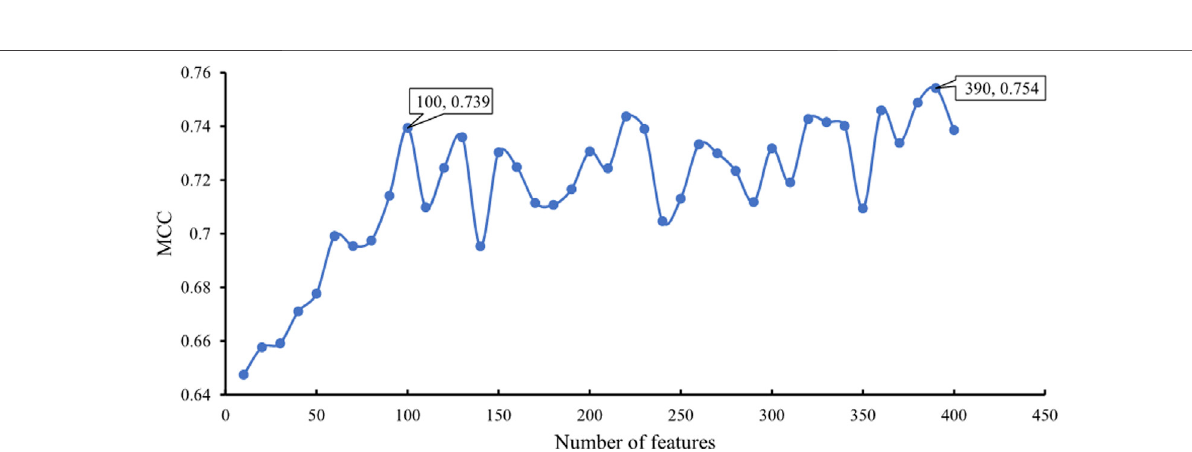
Frontiers in Cell and Developmental Biology |